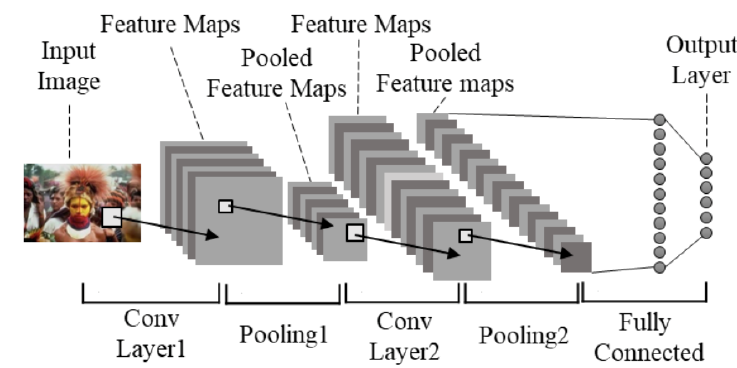
Figure 1. The representative convolutional neural network (CNN) structure [21].